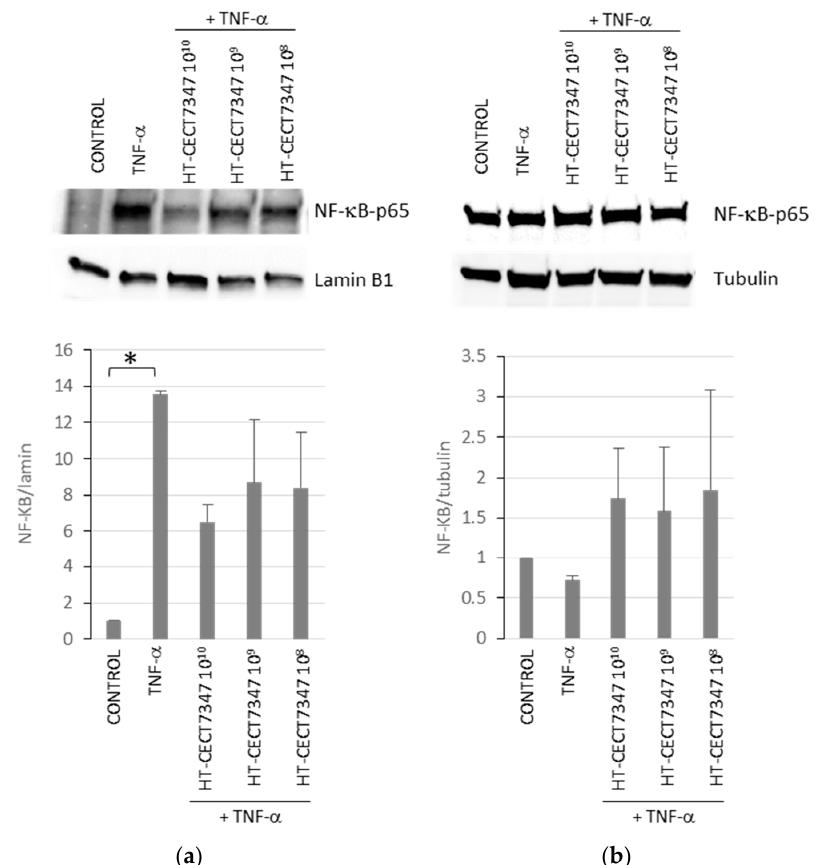
Figure 5. Analysis of the effect of HT-CECT-7347 on TNF- α -induced nuclear translocation of NF-kB p65 subunit in HT-29 cells. Western blot analysis for NF-kB-p65 subunit levels in nuclear ( a ) or cytosolic ( b ) fractions of HT-29 cells treated with TNF- α with or without HT-CECT-7347. Expression results were quantified by Image Studio software (LI-COR Biosciences) and represented as a graph. Data represents the means (+/ − SD) of two independent experiments. * indicates significantly higher than control ( p <